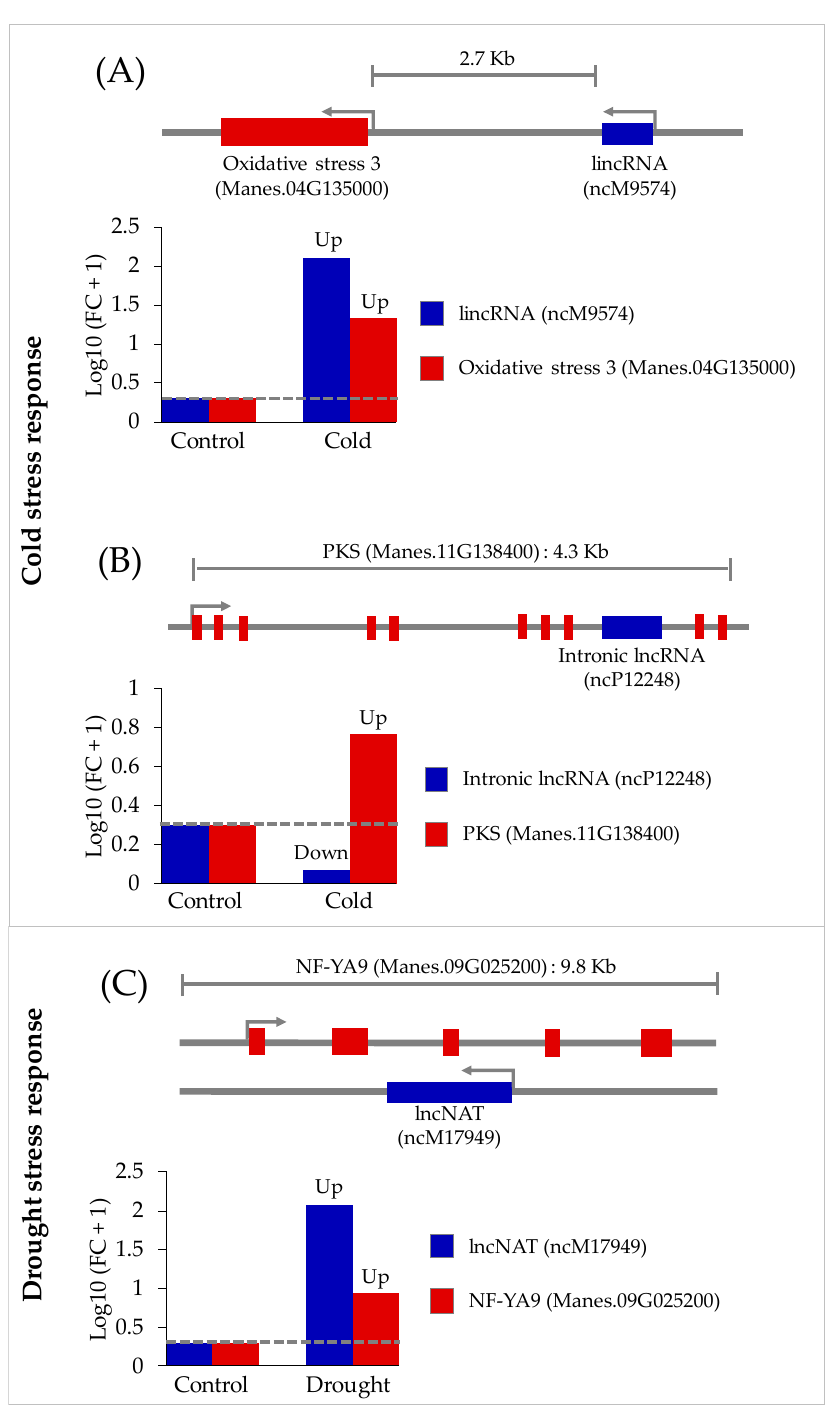
Figure 5. Potential novel lncRNAs that responded to cold or drought stress by cis -regulatory relationships with target genes. ( A ) Locus and fold change (FC) of lincRNA, ncM9574 and predicted target gene encoding oxidative stress 3 (Manes.04G135000) in cassava reference genome AM560v6. ( B ) Locus and fold change (FC) of intronic lncRNA, ncP12248 and predicted target gene encoding polyketide synthase enoyl reductase family protein (PKS) (Manes.11G138400), in cassava reference genome AM560v6. ( C ) Locus and fold change (FC) of lncNAT, ncM17949 and predicted target gene-encoding nuclear factor Y subunit A9 ( NF-YA9 ) (Manes.09G025200) in cassava reference genome AM560v6. FC control = Expression control / Expression control ; FC cold = Expression cold / Expression control ; FC drought = Expression drought / Expression control.